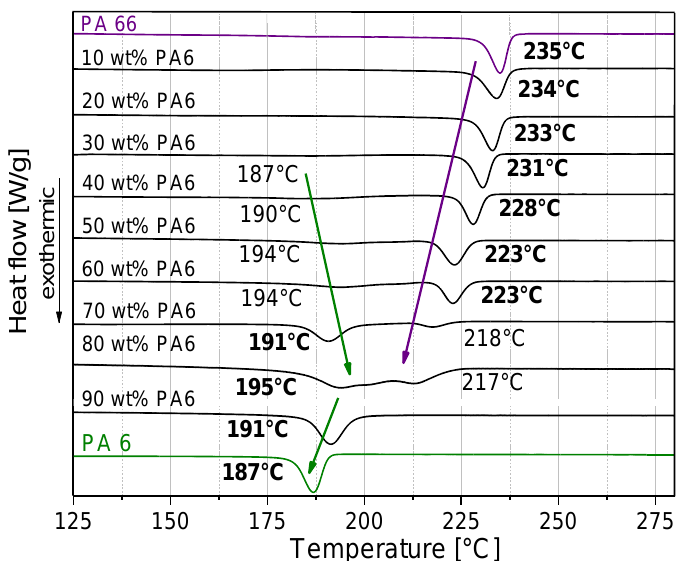
Figure 3. Crystallization behavior and maximum crystallization temperatures T c,max at different PA6/PA66 blend compositions.